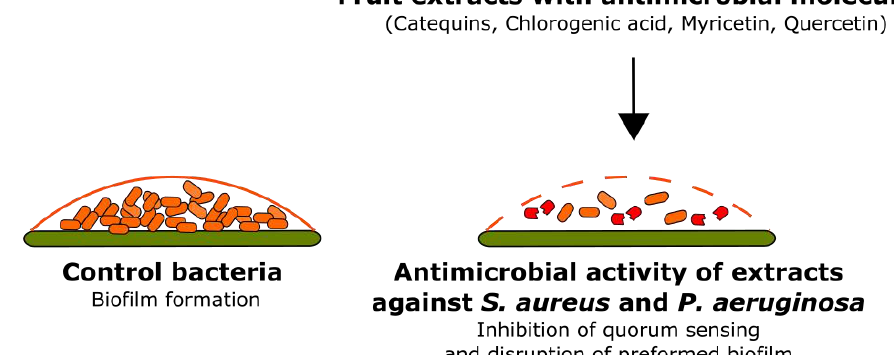
Figure 4. Graphical abstract of antimicrobial activity of fruit extracts of arrayan and peumo. Both extracts inhibit the growth of S. aureus and P. aeruginosa pathogenic bacteria potentially associate to its high content of antioxidant molecules. More details are presented in the text. Chemical structures credits [23].